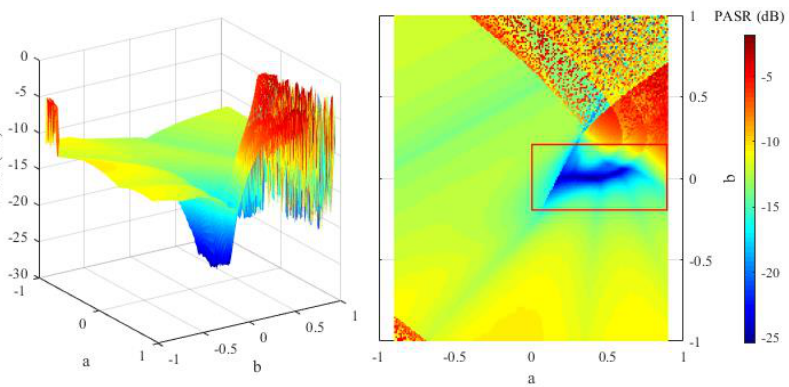
Figure 4. PASR values of different NLFM parameters under group 1 of sub-chirp rate PM code matrix and sub-chirp sequence code matrix.